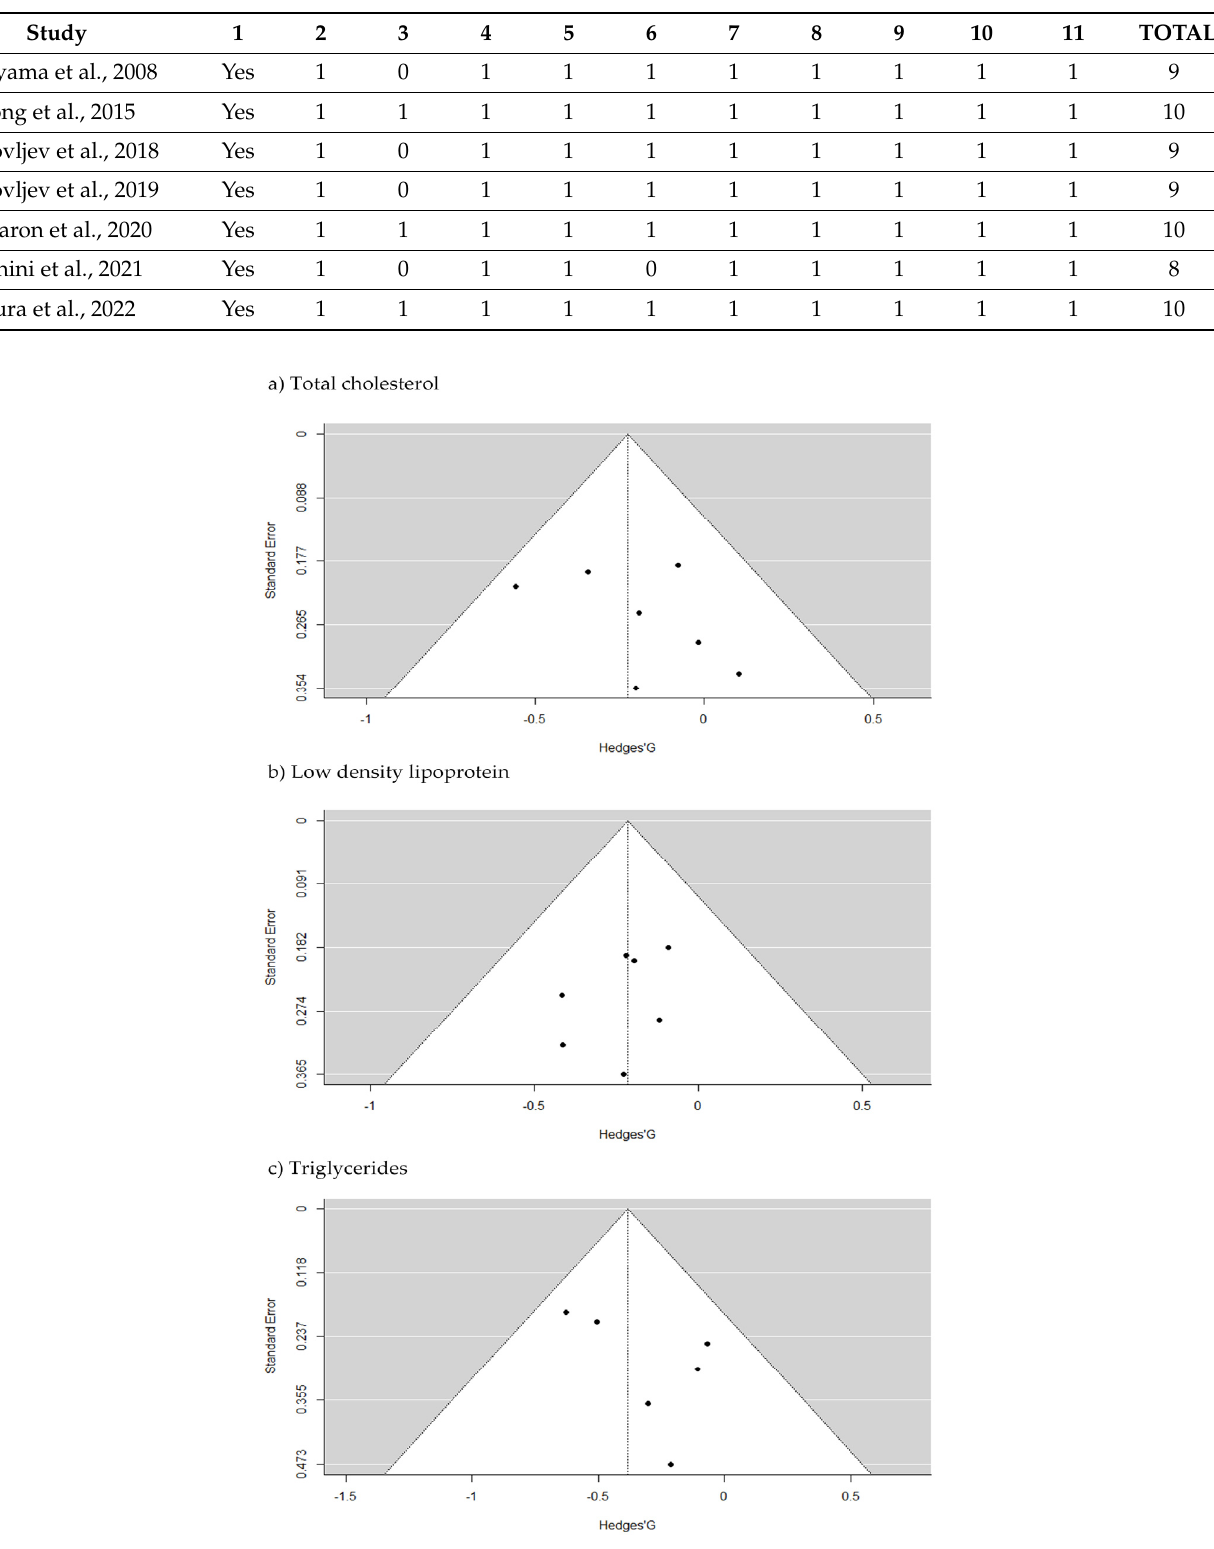
Table 2. Table PEDro ratings of the included studies.